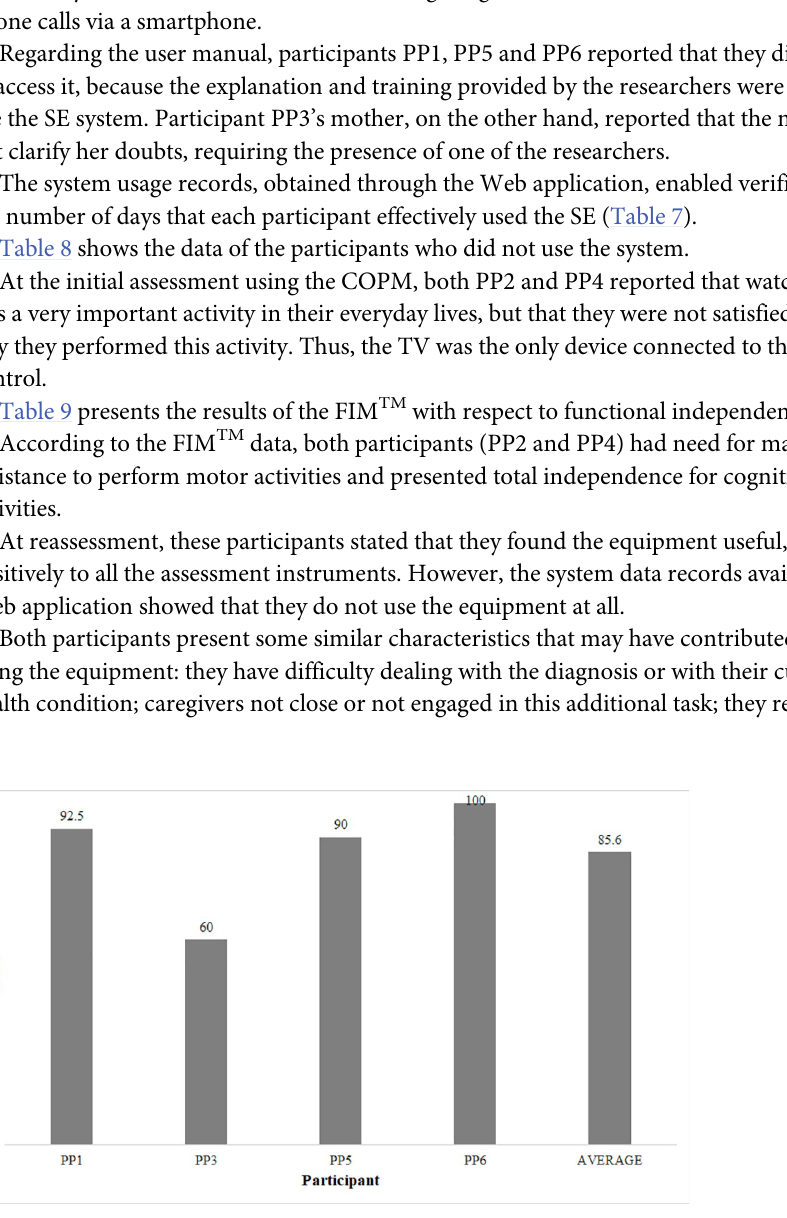
Fig 5. SUS results of participants who used the